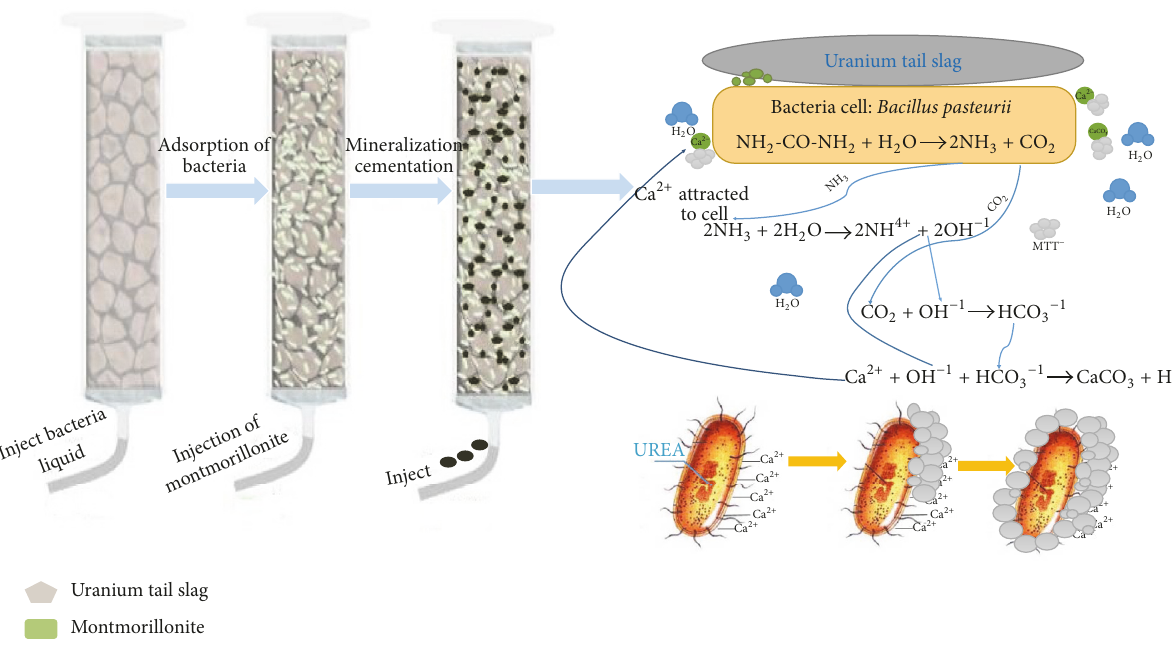
Figure 8: Schemes for uranium tailings mineralized by